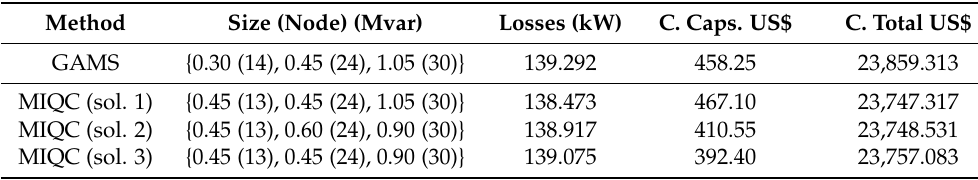
Table 5. Optimal location, sizes, and annual expected costs for the IEEE 33-bus system under peak load